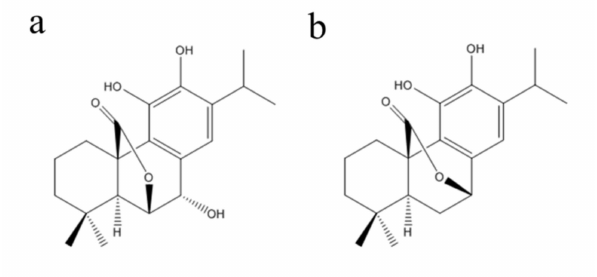
Figure 1. Chemical structures of rosmanol ( a ) and carnosol ( b